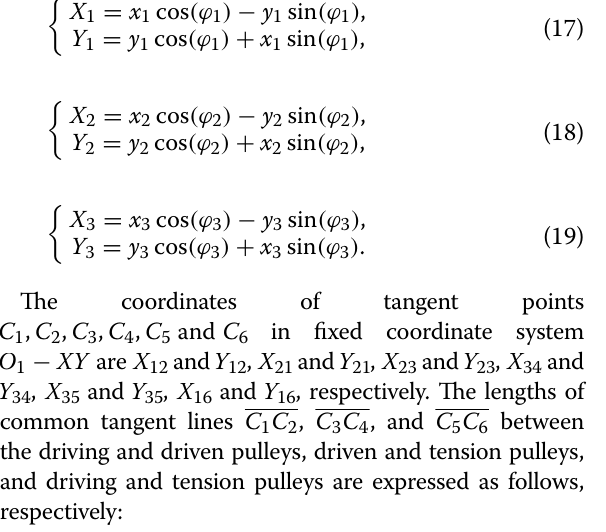
In Eq. (16), C 1 C 2 , C 3 C 4 , and C 5 C 6 are the lengths of the common tangents between the two pulleys, and ⌢ ⌢ C 4 C 5 , and C 6 C 1 are the arc lengths corresponding to the wrapping angles formed between the two tangential points